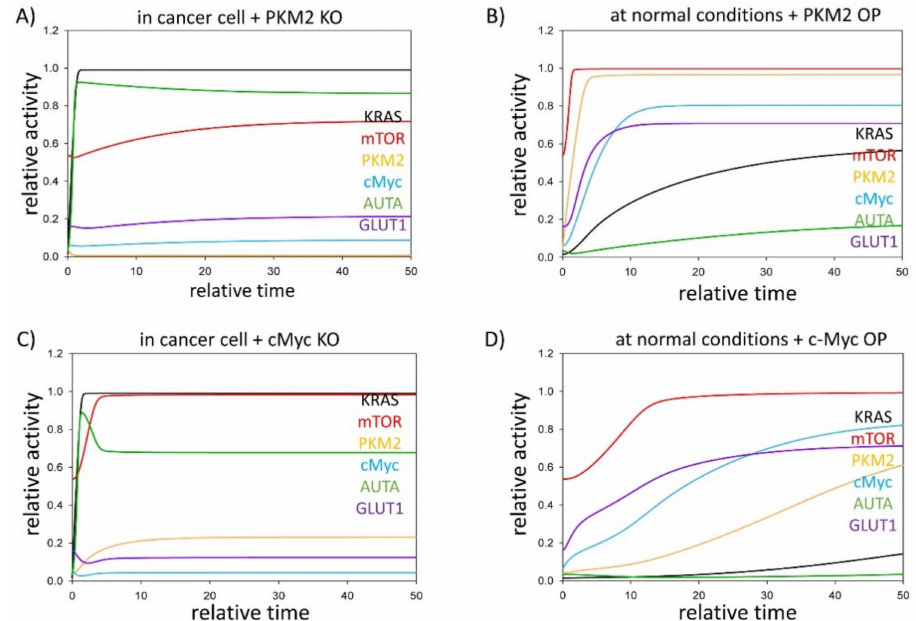
Figure 2. PKM2 level might have a therapeutic role in KRAS mutant cancer cells. The computational simulations were determined in normal conditions when PKM2 is ( A ) depleted (PKM2T = 0.01) in cancer cells (karas = 1), or ( B ) over-expressed (kapkm = 0.5) in physiological conditions (karas = 0.1). The dynamical characteristic of c-Myc is plotted when tumour progression is combined with cMyc: ( C ) depletion (cMycT = 0.1, karas = 1) or ( D ) c-Myc is over-expressed in physiological conditions (cMycT = 10, karas = 0.1). The relative activity of KRAS, PKM2, mTOR, cMyc, autophagy (AUTA) and GLUT1 is shown. For detailed description of the elements and constants of the theoretical models, see Tables A1 and A2,